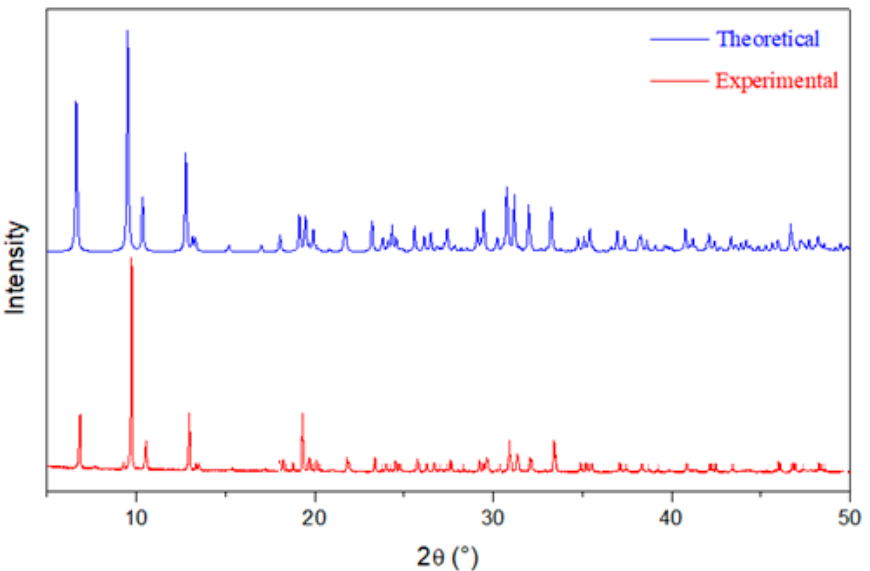
Figure 2. Theoretical and experimental XRPD of (C 6 H 8 Cl 2 N 2 ) 2 [Cd 3 Cl 10 ] · 6H 2 O.